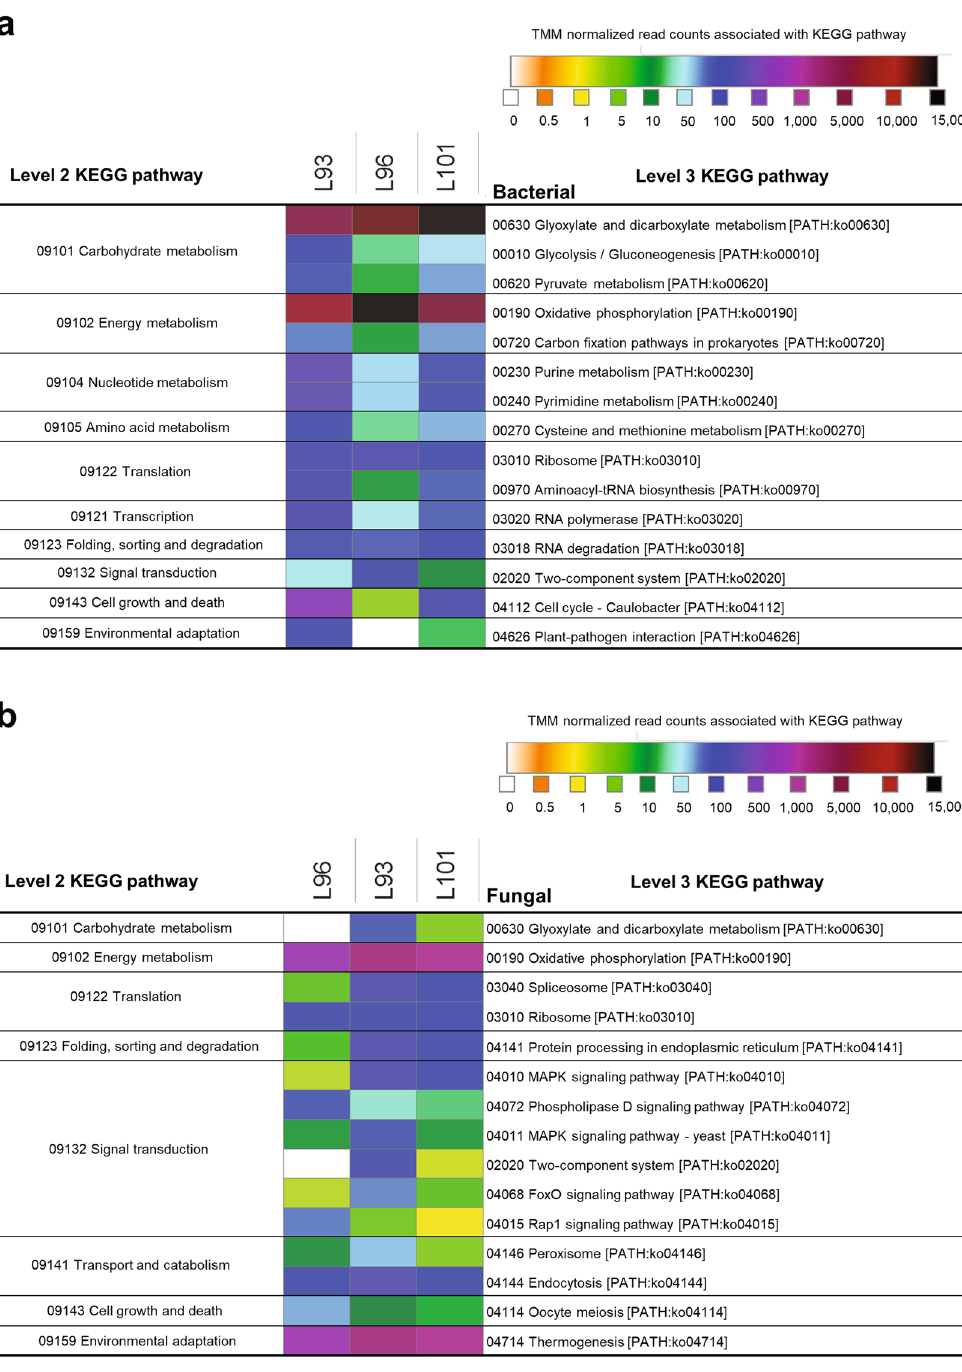
Fig. 3 Clustering of the top 15 bacterial and fungal metatranscriptomics data according to their KEGG pathway pro fi les. Heatmap shows the top 15 distribution of protein-coding reads matching KEGG pathways in the a bacterial and b fungal community. The color scale shows the TMM-normalized read counts associated with each pathway. Only pathways representing more than fi ve normalized read counts across all three samples are represented. A full version of each of these heatmap can be found in the Supplementary Figs. 2 and